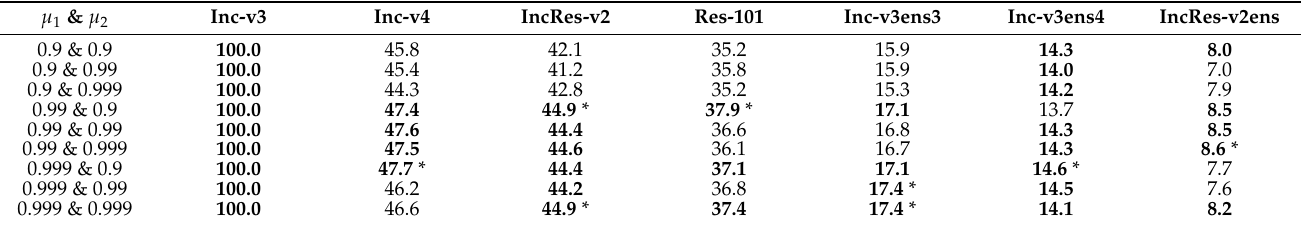
Figure 4. Attack success rates (%) of NAI-FGM on three networks using adversarial examples produced on Inc-v3 with different decay factors. Table 6. Attack success rates (%) of NAI-FGM on seven networks using adversarial examples produced on Inc-v3 with different combinations of decay factors. The data marked with * indicate the highest success rate on each black-box model, and the bolded data indicate the success rate that is in the largest integer interval in each